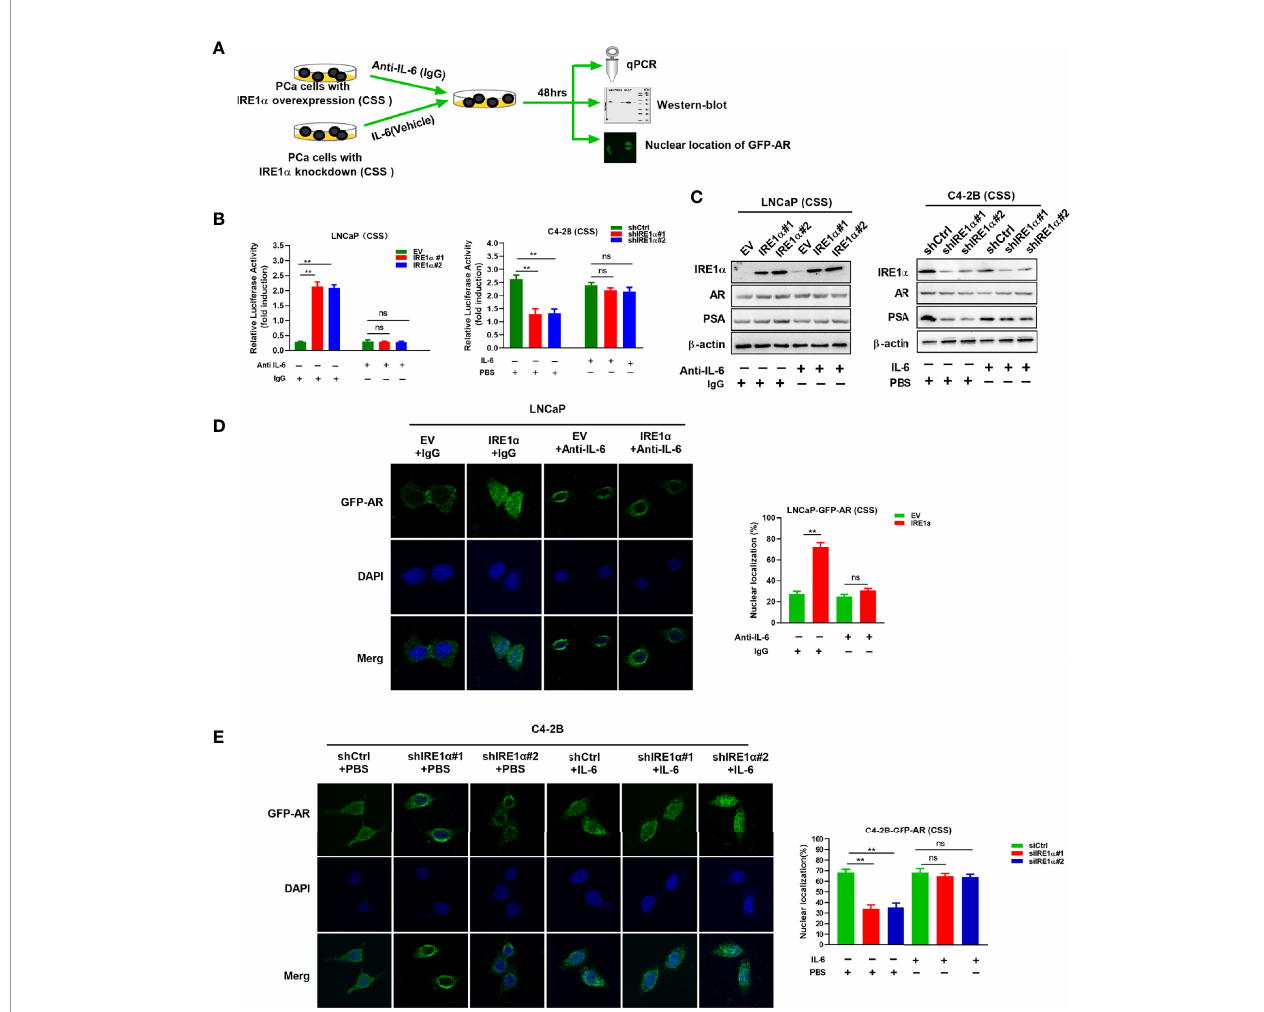
FIGURE 5 | IRE1 a activates AR by inducing IL-6 secretion. (A) LNCaP cells with IRE1 a overexpression and C4-2B cells with IRE1 a knockdown were treated with anti-IL-6 antibodies or IL-6 respectively, and AR transcriptional activity was measured by luciferase reporter assay, western-blot and nuclear localization of GFP-AR after 48 hours of treatment. (B) LNCaP cells with IRE1 a overexpression and C4-2B cells with IRE1 a knockdown were transiently transfected with PSA-Luc and then treated with anti-IL-6 antibodies or recombinant IL-6, respectively. Luciferase activity was assayed and normalized. (C) Western blot assays were performed to determine the expression levels of IRE1 a , AR, and AR target gene PSA in LNCaP cells with IRE1 a overexpression or C4-2B cells with IRE1 a knockdown, which have been treated with anti-IL-6 or recombinant IL-6, respectively. (D, E) Fluorescent microscopy was used to detect whether IL-6 affected IRE1 a -induced nuclear localization of GFP-AR. Data shown are the mean ± SD from three independent experiments, **P < 0.01; ns, no signi fi